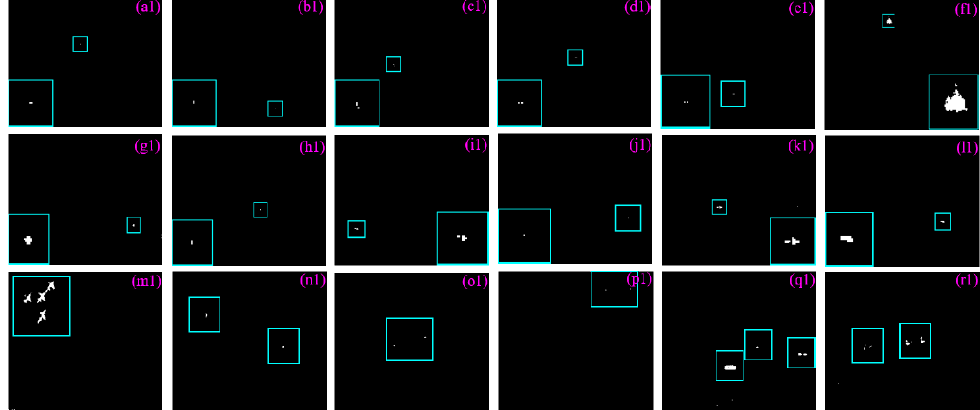
Figure 7. The detection results of the proposed model. The targets are labeled and/or enlarged for better visualization. ( a1 )–( r1 ) are the corresponding detecting results of the proposed method in Figure 5a–r.